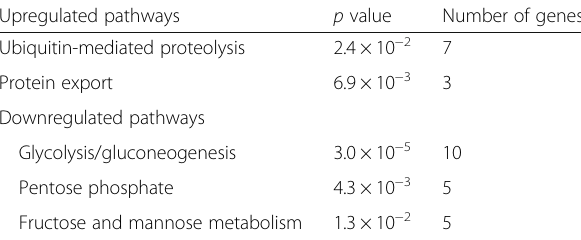
ure S2, Additional file 6: Figure S3, Additional file 7: Figure S4, and Additional file 8: Figure S5.